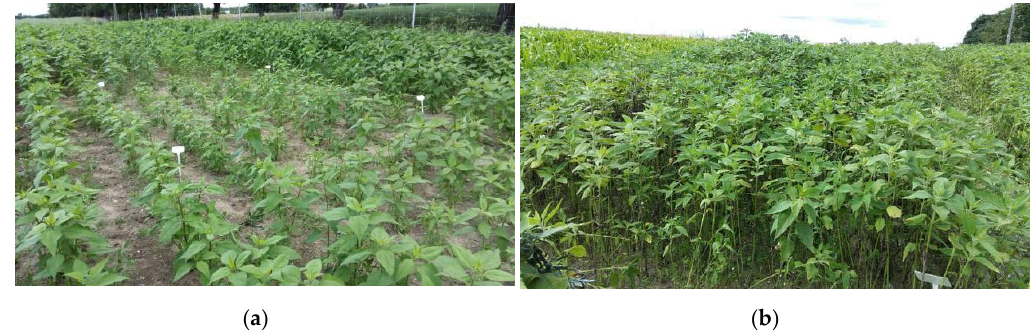
Figure 12. Jerusalem artichoke plants fertilized with various doses of biogas plant waste in Piaszczyna, (north Poland). The plot on the left fertilized with the dose of 10 m 3 ha −1 , in the middle the control (0 m 3 ha −1 and on the right 40 m 3 ha −1 . Photo was taken on June 15 ( a ) and 2 of July ( b ).